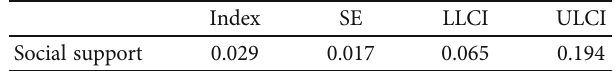
Table 7: Index of moderated